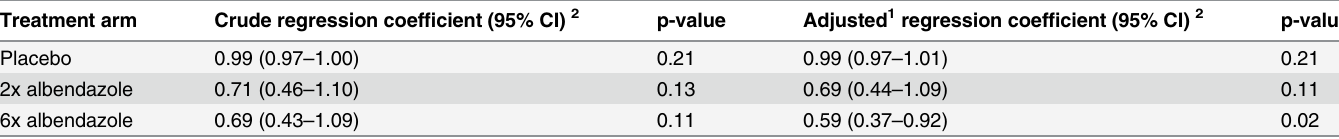
Table 5. Longitudinal trend in Loa loa microfilaraemia from baseline up to 11 – 12 months after completion of each